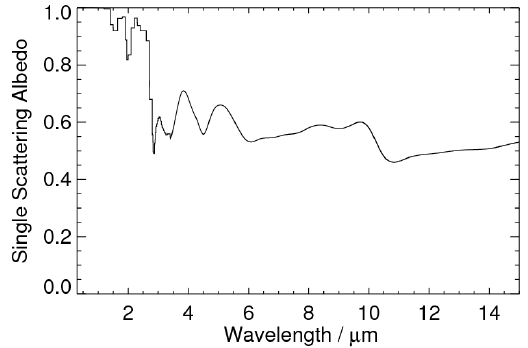
Fig. 3. Single scattering albedo for hexagonal ice crystals of 30µm effective radius for the ice cloud parameterisation